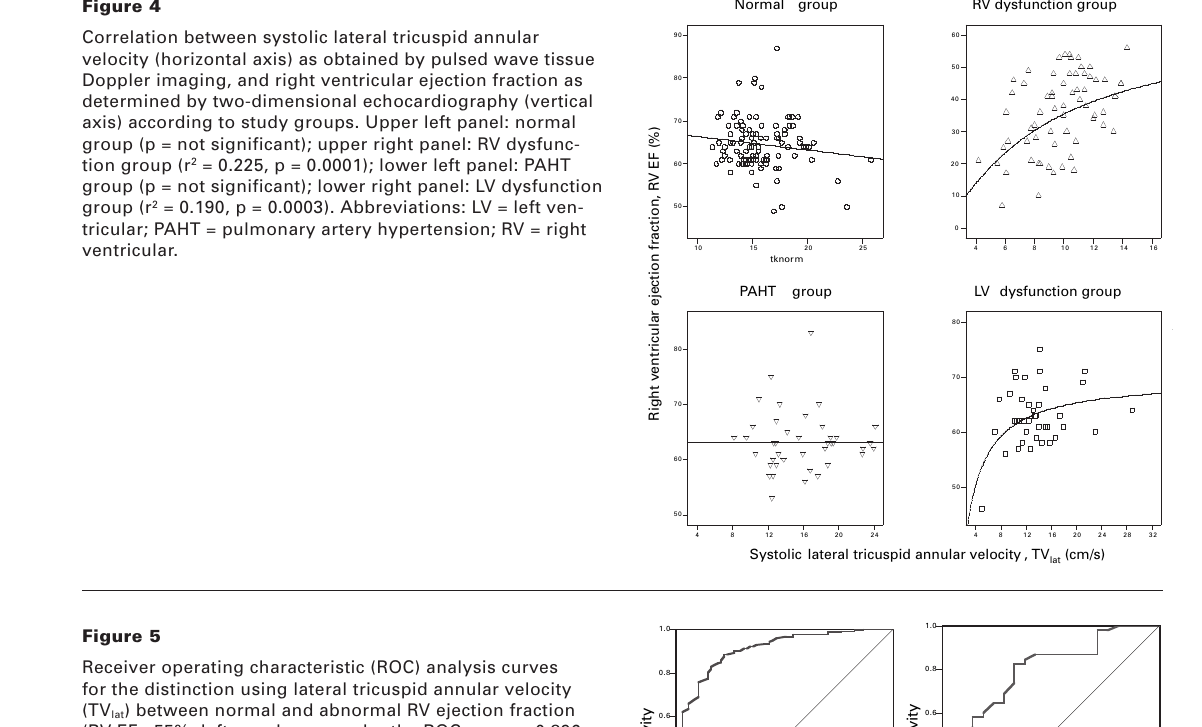
Figure 4 Correlation between systolic lateral tricuspid annular velocity (horizontal axis) as obtained by pulsed wave tissue Doppler imaging, and right ventricular ejection fraction as determined by two-dimensional echocardiography (vertical axis) according to study groups. Upper left panel: normal group (p = not significant); upper right panel: RV dysfunc- tion group (r 2 = 0.225, p = 0.0001); lower left panel: PAHT group (p = not significant); lower right panel: LV dysfunction group (r 2 = 0.190, p = 0.0003). Abbreviations: LV = left ven- tricular; PAHT = pulmonary artery hypertension; RV = right ventricular.